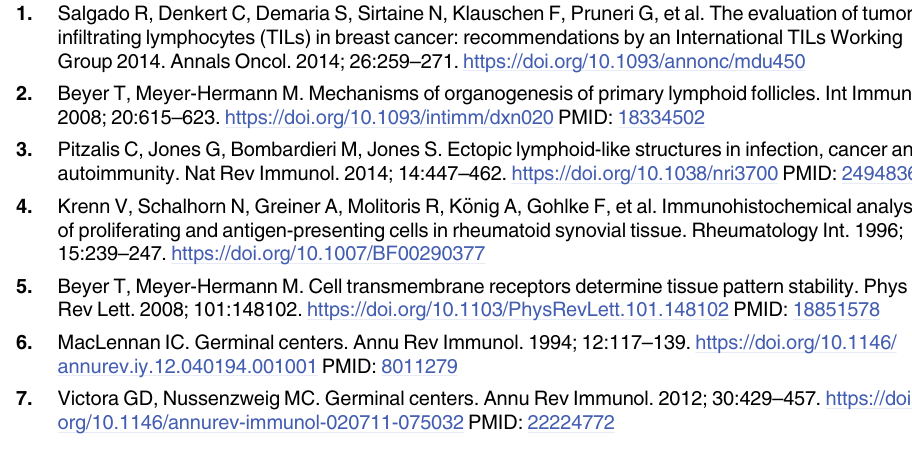
S6 Fig. Distribution. Gray border represents significant difference between corresponding class and all remaining classes of same tissue type by Mann–Whitney U test using a signifi- cance level of 0.001. A: homogeneity H . B: clustering coefficient C . S1 Table. Feasibility of support vector machine using 5-fold cross validation, measured in the test set of each fold and then averaged over all